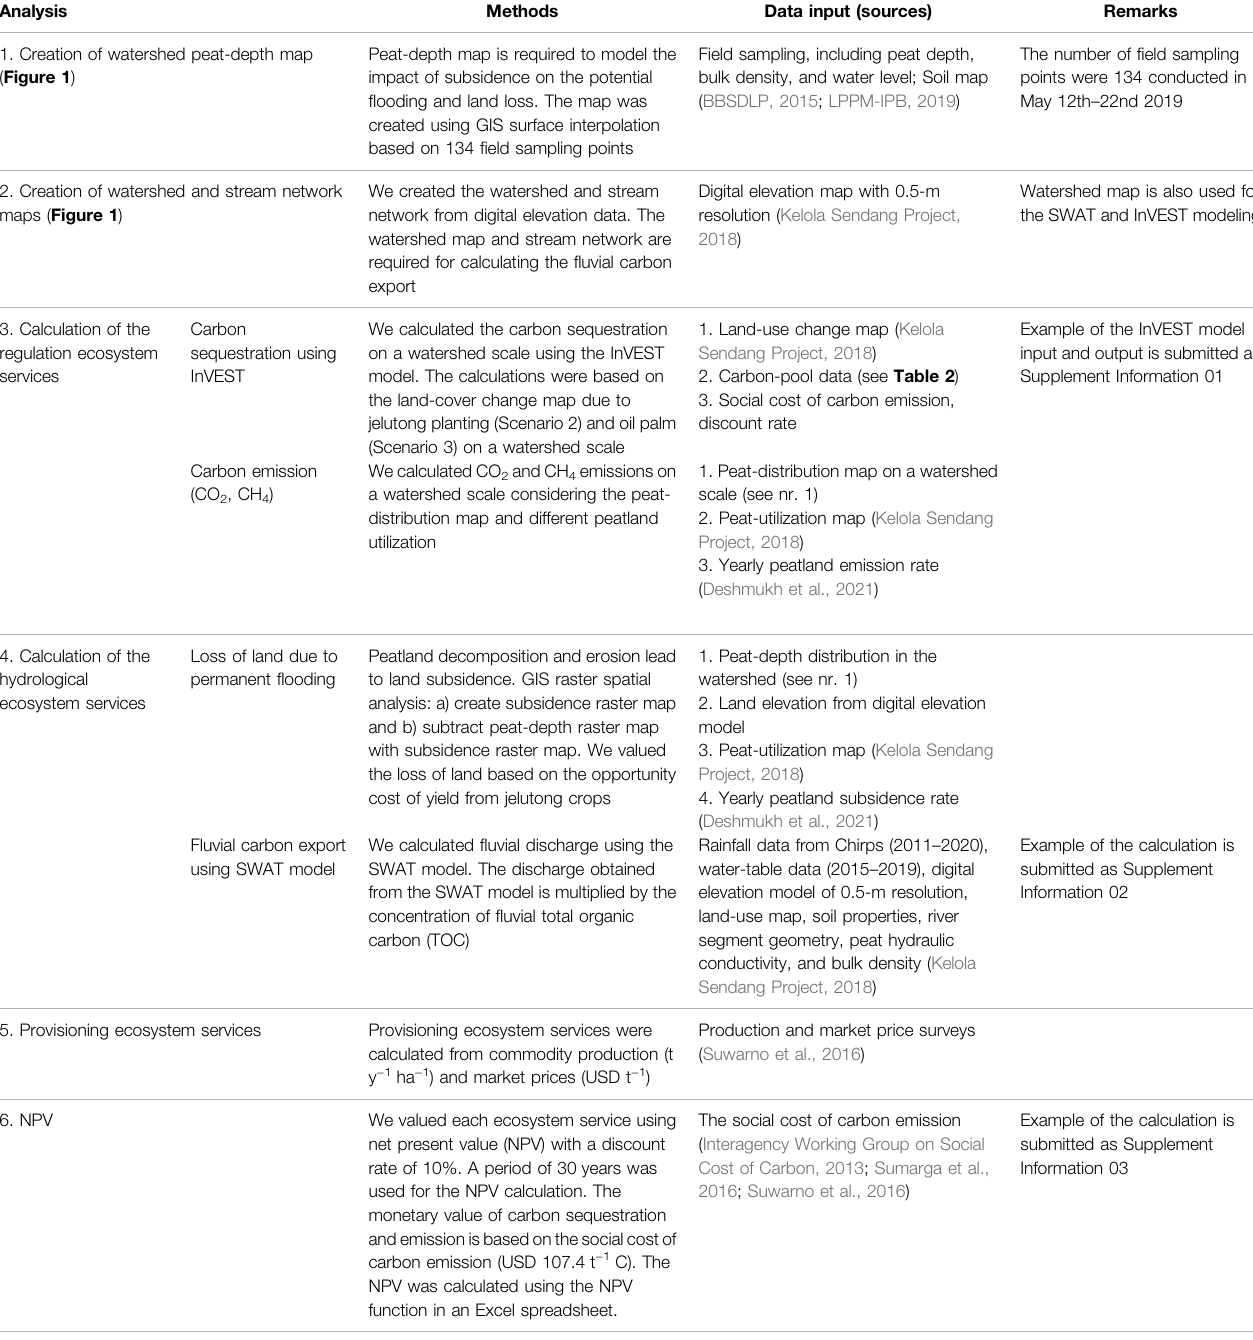
TABLE 3 | Method and data